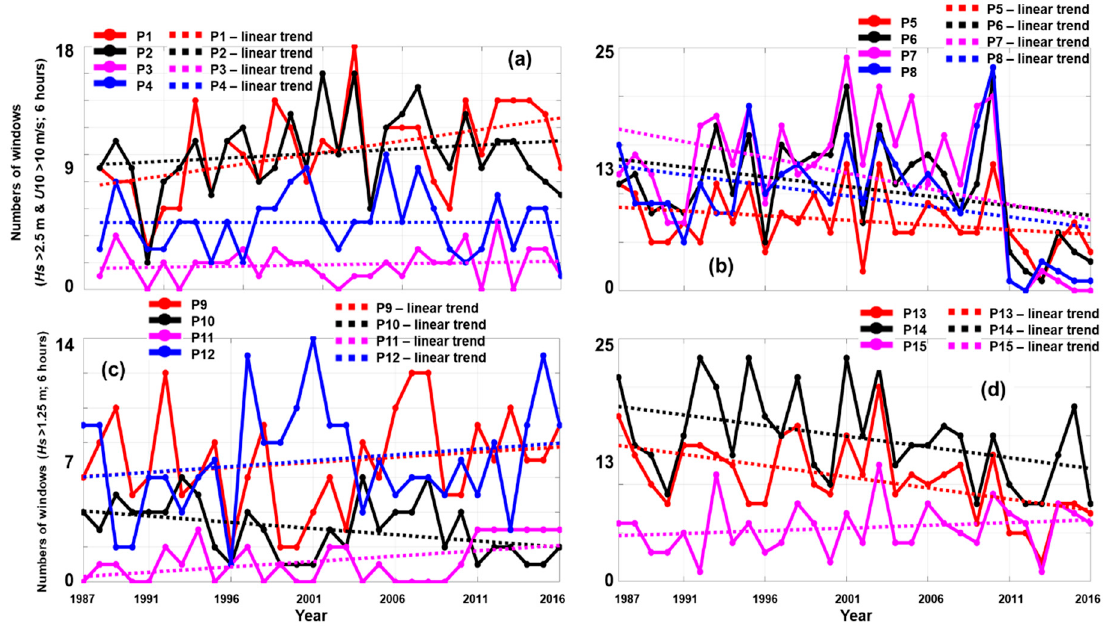
Figure 14. Number of windows of 6 h above 2.5 m ( Hs ) and 10 m/s ( U 10) threshold, where: ( a ) P1–P4